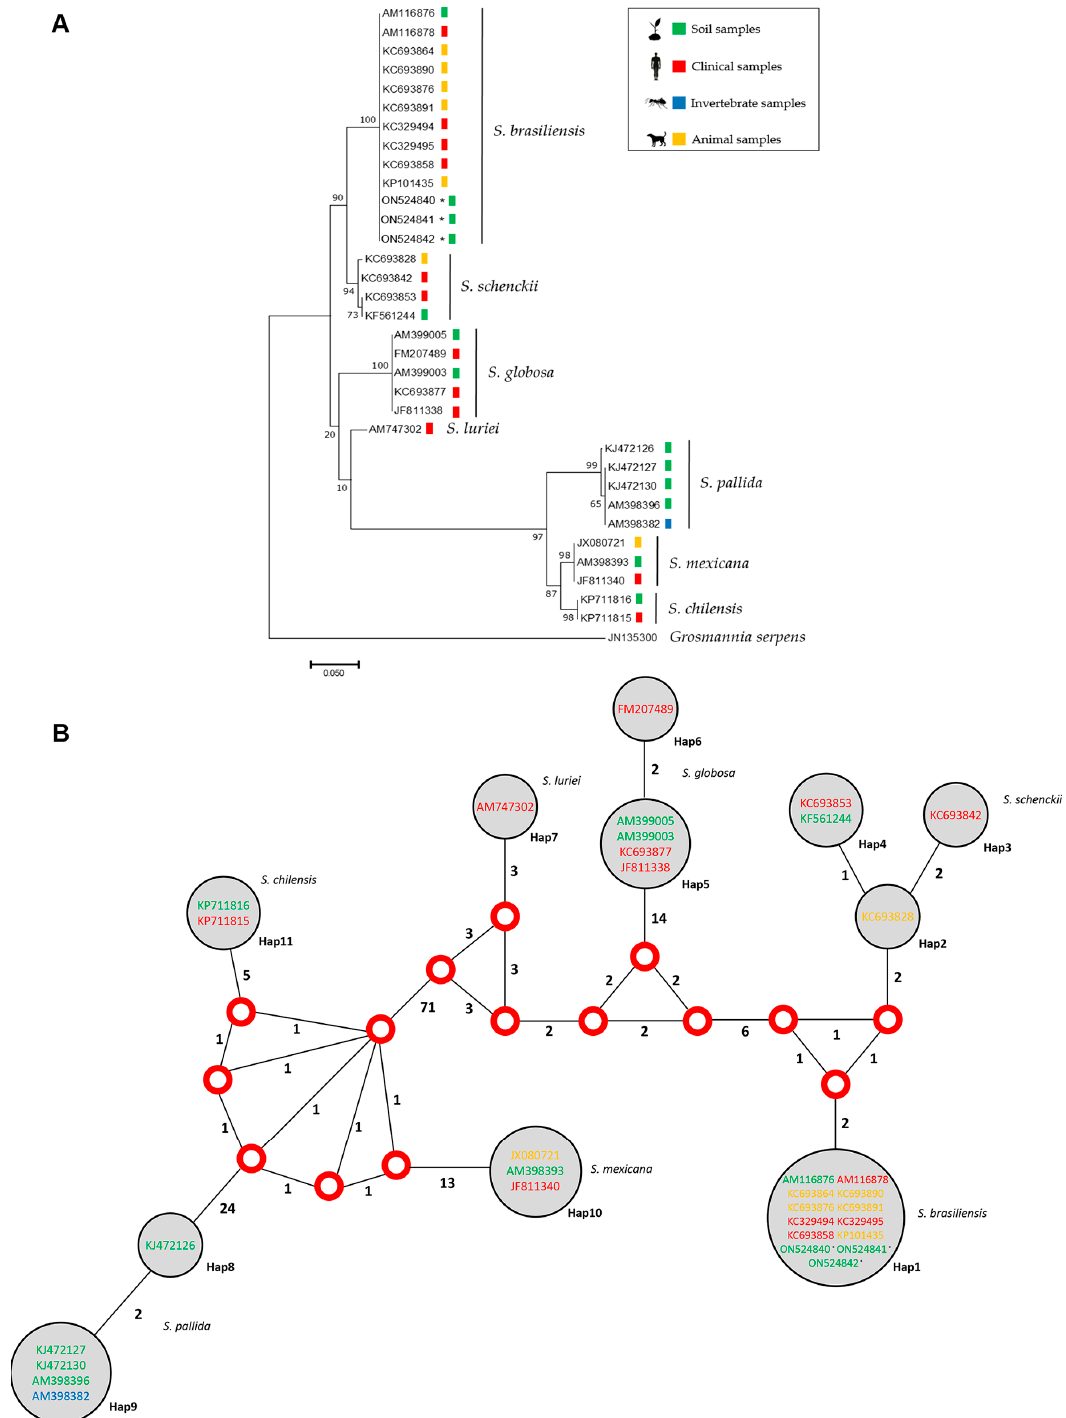
Figure 3. ( A ) Maximum likelihood phylogenetic relationships based on calmodulin partial sequenc- ing between members of clinical, animal and environmental isolates from the Sporothrix species with clinical interest. The colored squares represent the origin source of each isolate/sequence. ( B ) Median vector haplotype network demonstrating the phylogenetic relationships among the 33 isolates/sequences of the present study, demonstrating that, in both cases, the three sequences obtained grouped with S. brasiliensis . Red dots represent median vectors. Circle size is proportional to the frequency of isolates (h). The numbers around each vertex represent the amount of mutations sep- arating each haplotype and the different colors in the Genbank code represent the isolate/sequence origins. * Indicate sequences generated in this